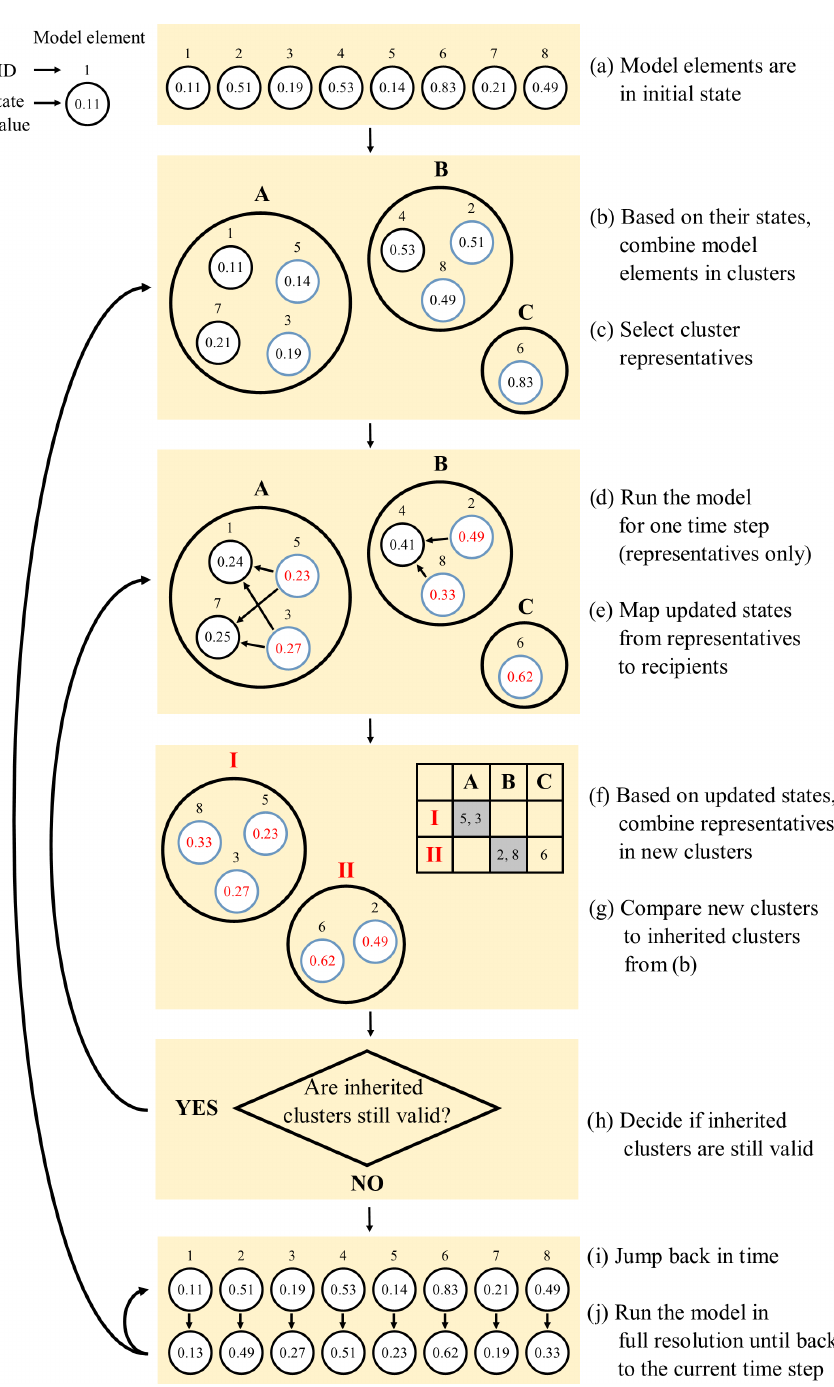
representatives. This is much more efficient than consid- ering all model elements. Comparing clusters involves identifying matching clusters and then measuring their degree of agreement. In the plot, this is illustrated by a table where each column represents one of the inherited